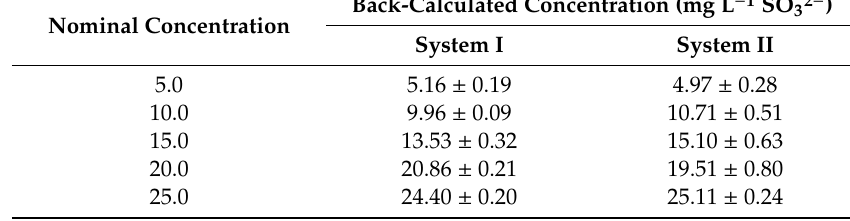
Table A1. Quantitative results of back-calculated concentrations from calibration graphs obtained from the Systems I and II.